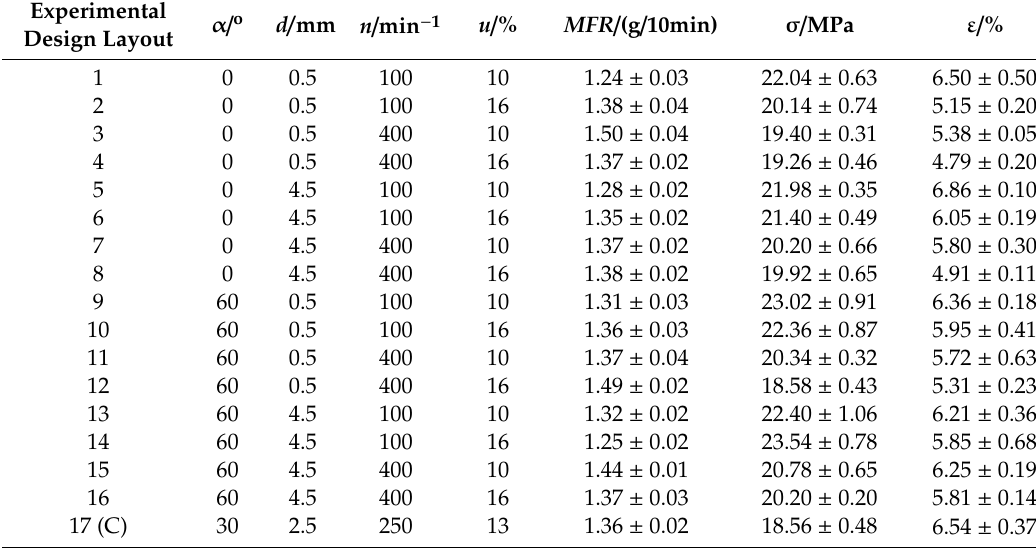
Table 1. Experimental design and results of tests on the properties of the obtained extrudate—mean values with standard